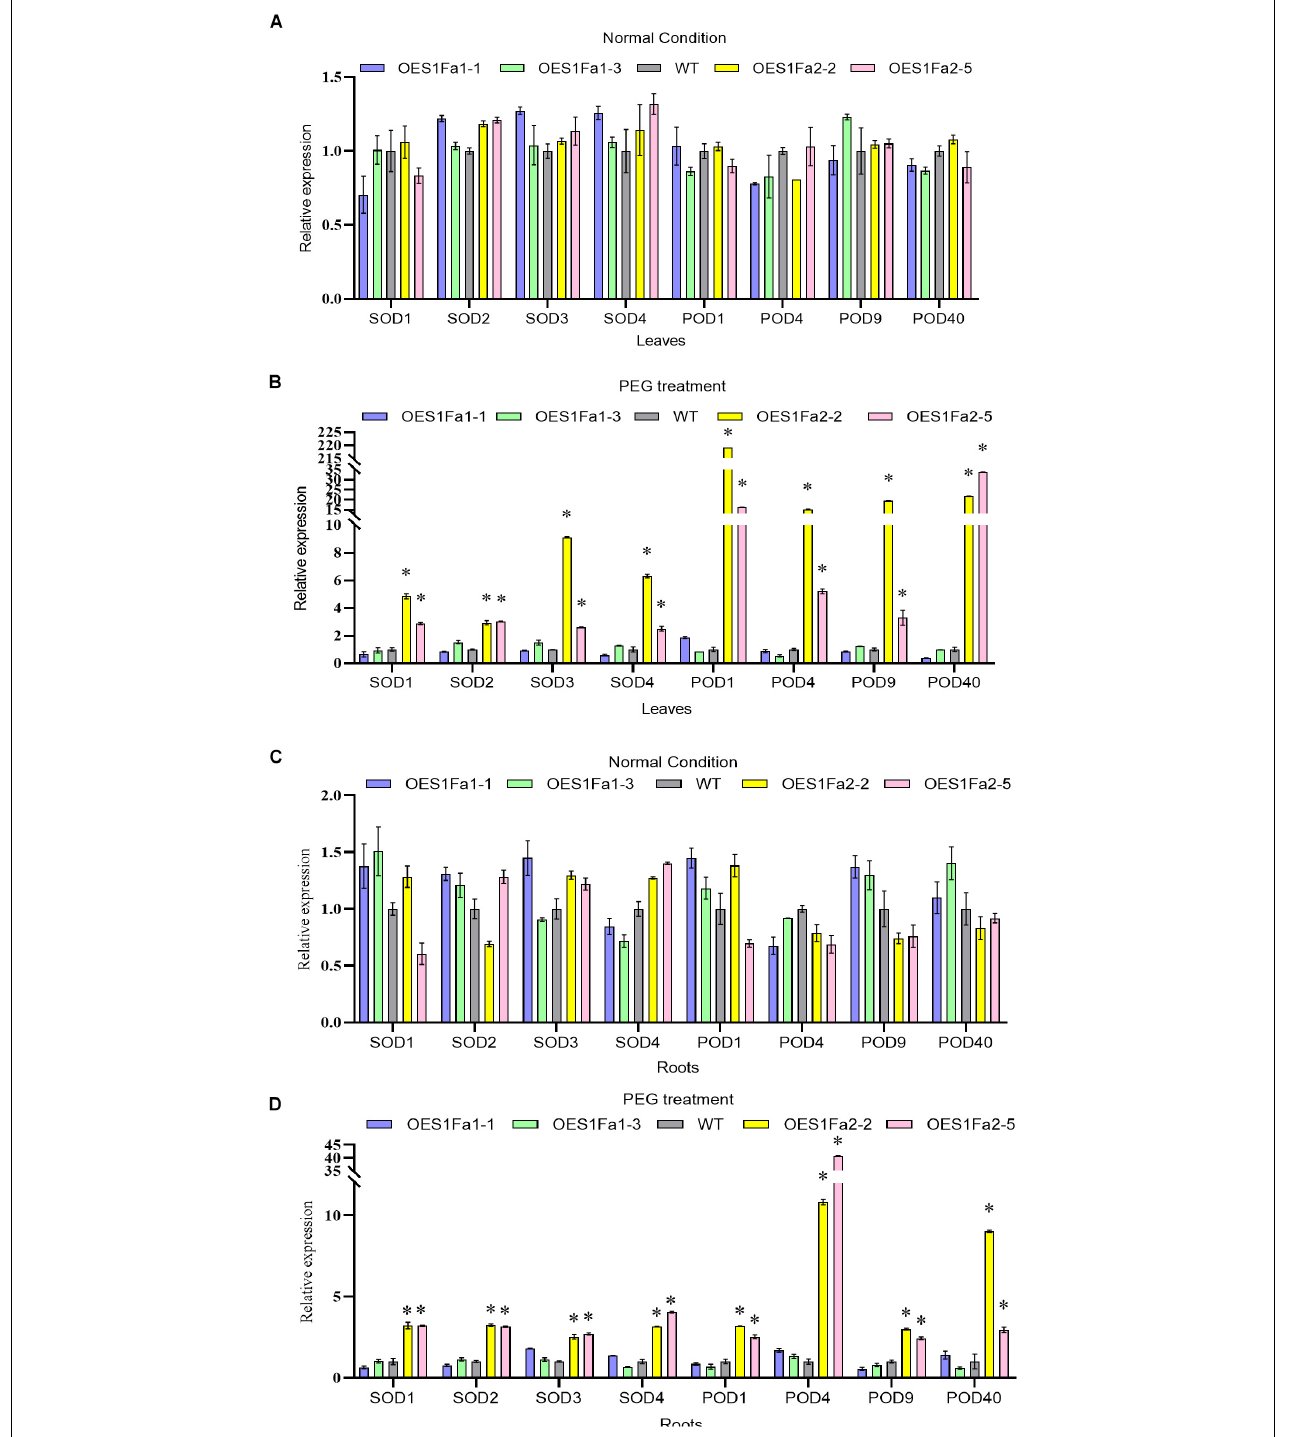
FIGURE 8 | Determination of the expression of POD and SOD genes regulated by PtS1Fa1 and PtS1Fa2 . Analysis of the expression of POD and SOD genes in leaves of WT, PtS1Fa1 and PtS1Fa2 transformed lines (OEPtS1Fa1, and OEPtS1Fa2) using qRT-PCR under normal condition (A) or under PEG treatment conditions (B) . The expression of POD and SOD genes in roots of WT, OEPtS1Fa1, and OEPtS1Fa2 using qRT-PCR under normal condition (C) or under PEG treatment conditions (D) . Plants were treated with 20% (w/v) PEG6000 for 9 h, and samples were harvested for determination gene expression. The transcript level of genes in WT plants were used as control (set as 1) to normalize the gene expression in transgenic lines. Error bar represents the standard deviation (STD) of the three biological replicates. Asterisk ( ∗ ) indicates the significant differences at P < 0.05 compared with the WT.